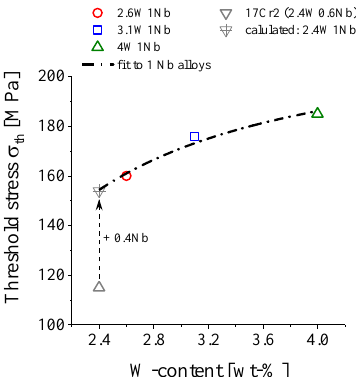
Figure 7. Impact of W and Nb on dislocation creep threshold stress (virtual 2.4W1Nb alloy, equation:  th = a × (1 − c W−b ); c W : W-content in wt.%, a: 215.27, b: 1.44). The threshold improved from about 115 MPa in case of the 17Cr2 (2.4W0.6Nb) base steel to appr. 160 MPa for the 2.6W1Nb material and further to about 185 MPa (4W1Nb) by increasing the concentration of W in the 1Nb model alloys. The threshold values evaluated for the 17Cr2 (2.4W0.6Nb) prototype and the 4W1Nb alloys correlate well with the mechanism changes, obtained in uniaxial creep experiments, executed at full-scale specimens taken from rolled plate materials of matching chemical compositions [9]. The 17Cr2 (2.4W0.6Nb) alloy surpasses the creep strength of grade 92, while the 4W1Nb steel combats the strongest available advanced ferritic-martensitic steel MarBN [9]. Mathematical backward extrapolation of the W-tungsten content to 2.4 wt.% for the virtual 2.4W1Nb alloy calculates to a threshold of 158 MPa. In consequence, the effect of sole Nb- addition ( + 0.4 wt.%) to the 17Cr2 base steel would result in an increase in threshold of appr. 40